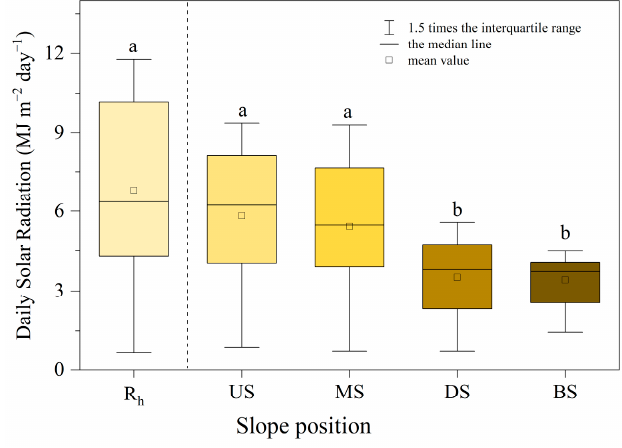
Figure 3. The differences in solar radiation income at various slope positions. ( R h represents the daily solar radiation income of horizontal ground; US represents the upper slope; MS represents the middle slope; DS represents the down slope; BS represents the bottom slope). 1.5 times IQR (interquartile range) was used to determine the anomalous values. Groups marked by different letters significantly differ from each other (i.e., a is significantly greater than b) (p ≤ 0.05).